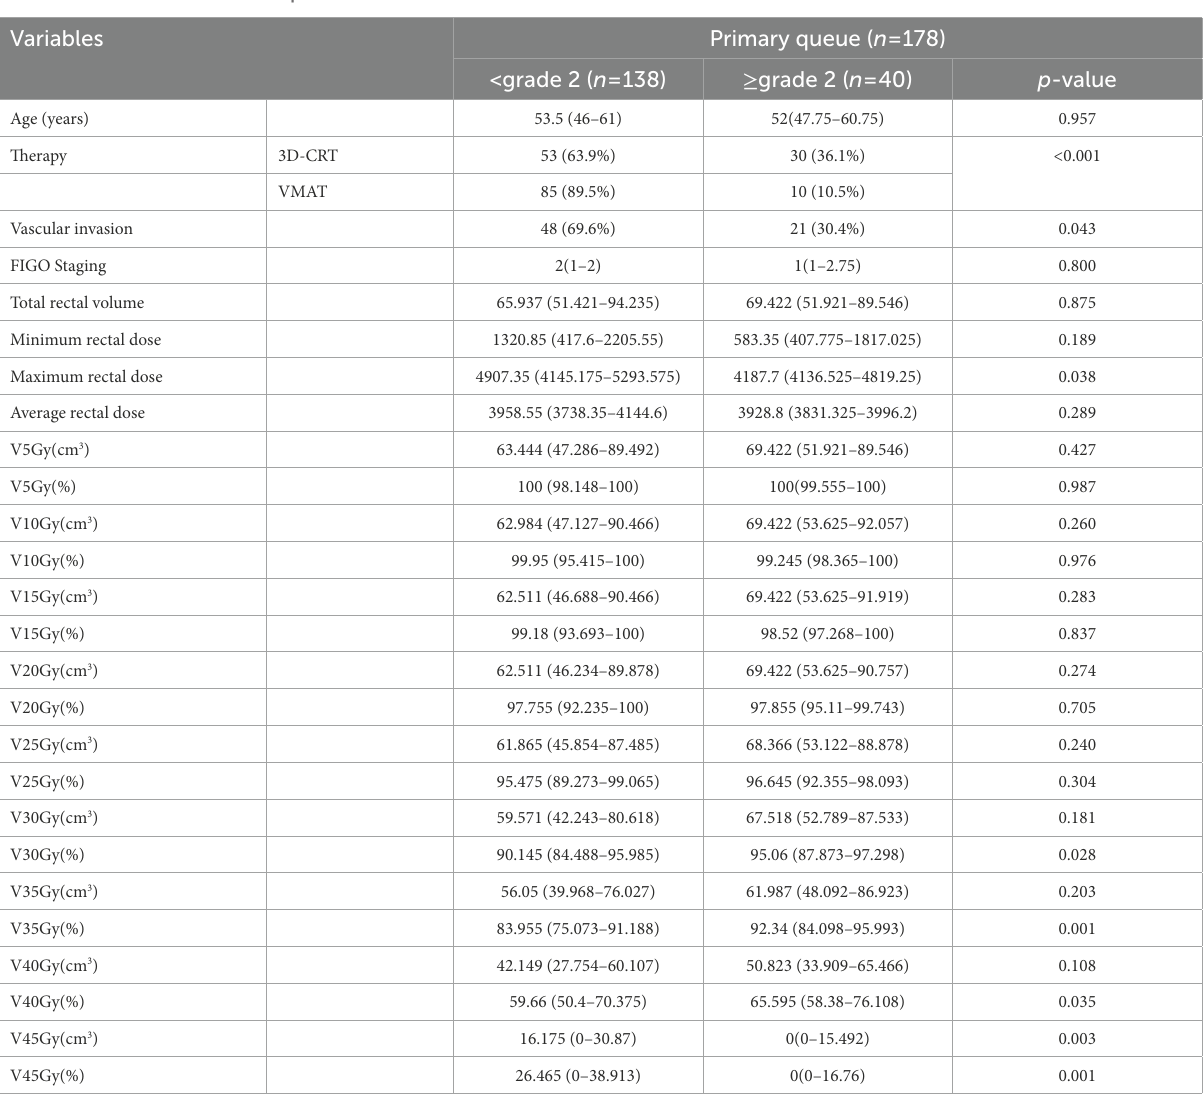
TABLE 1 Baseline information of all